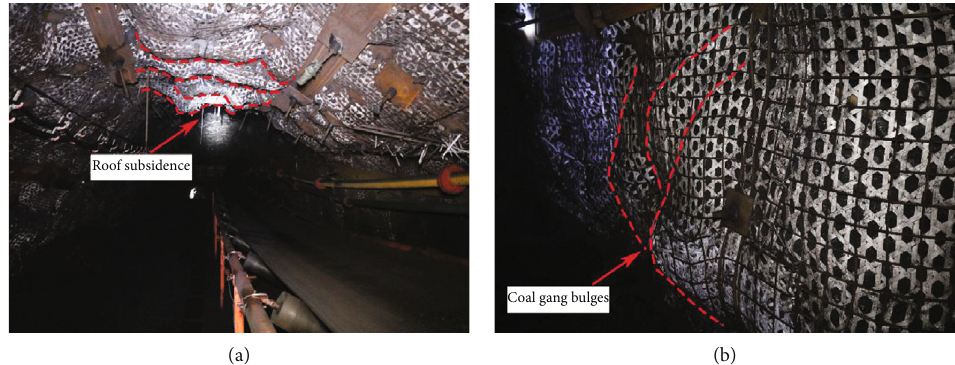
Figure 3: Deformation diagram of roadway a ff ected by mining. (a) roof subsidence and (b) coal gang